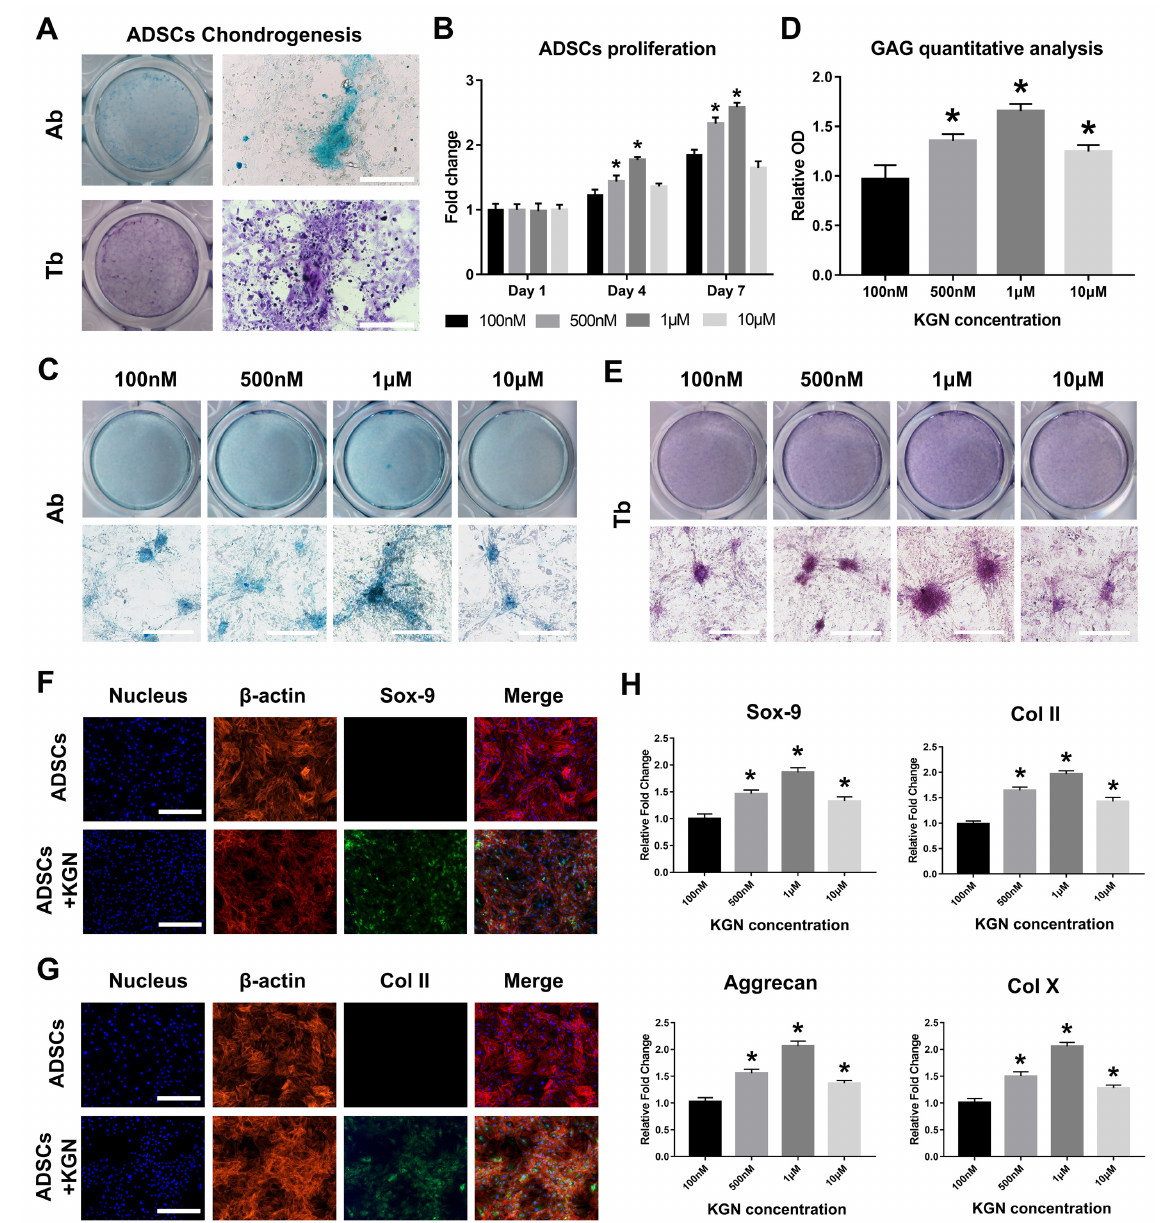
Figure 1. The chondrogenic differentiation of adipose derived mesenchymal stem cells (ADSCs) induced by kartogenin (KGN). ( A ) The verification of ADSCs chondrogenesis by transforming growth factor β 3 (TGF β 3) and the Ab and Tb stainings showed the successful chondrogenic differentiation, Bar: 200 µ m. ( B ) the Cell Counting Kit-8 (CCK8) analysis of the ADSCs proliferation treated with different KGN concentrations. * p < 0.05 indicates a significant difference compared to the corresponding 100 nM group at each time point. ( C ) The evaluation of different KGN concentrations on ADSC chondrogenic differentiation. The Ab stainings were used to test the effects of different KGN concentrations (100 nM, 500 nM, 1 µ M and 10 µ M), bar: 200 µ m. ( D ) The quantitative analysis of the alcian blue staining to evaluate the glycosaminoglycan (GAG) content. * p < 0.05 indicates a significant difference compared to the 100 nM group. ( E ) The evaluation of different KGN concentrations on ADSCs chondrogenic differentiation. The Tb stainings were used to test the effects of different KGN concentrations (100 nM, 500 nM, 1 µ M and 10 µ M), bar: 200 µ m. Immunofluorescence staining of the chondrogenic markers Sox-9 ( F ) and Col II ( G ) to clarify the ADSCs chondrogenesis, Bar: 200 µ m. ( H ) Real-time PCR quantitative analysis of the chondrogenic markers including Sox-9, Col II, Aggrecan and Col X. * p < 0.05 indicates a significant difference compared to the 100 nM